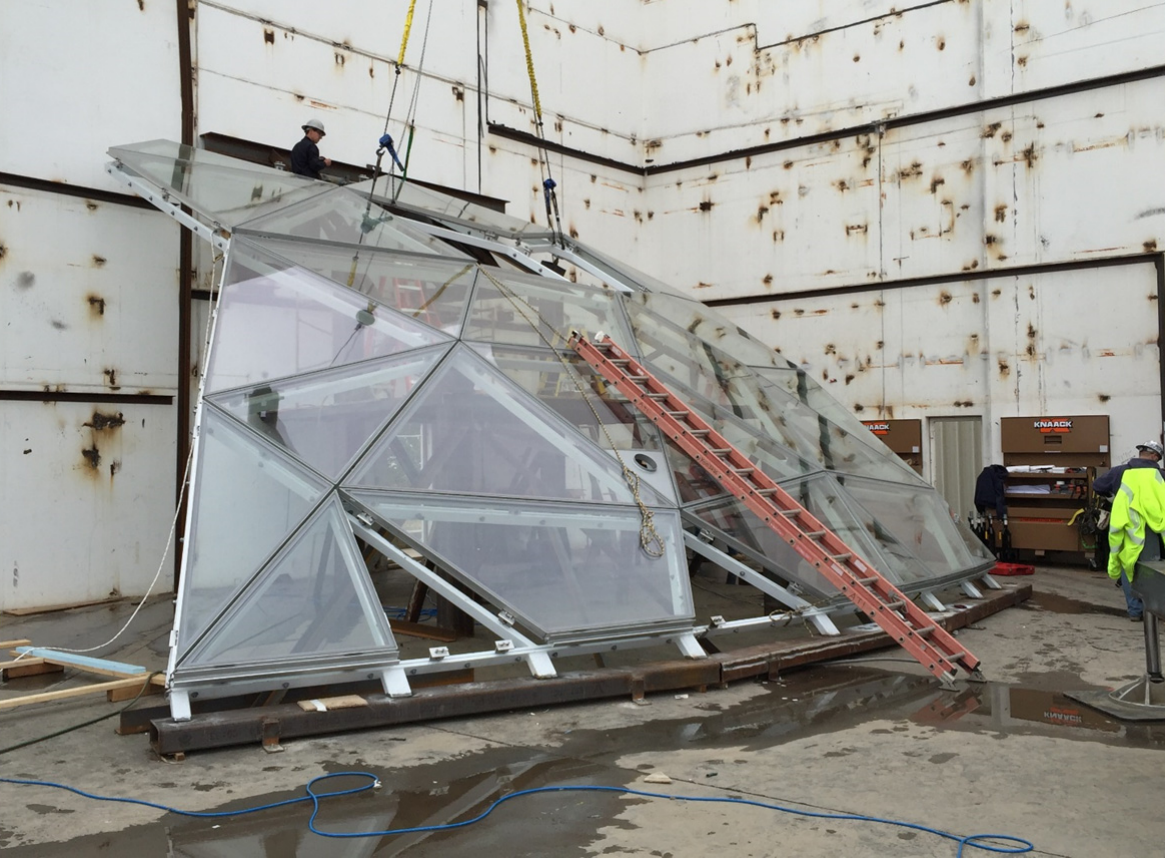
Fig. 10 Construction of Multi-faceted Façade Performance Mockup.